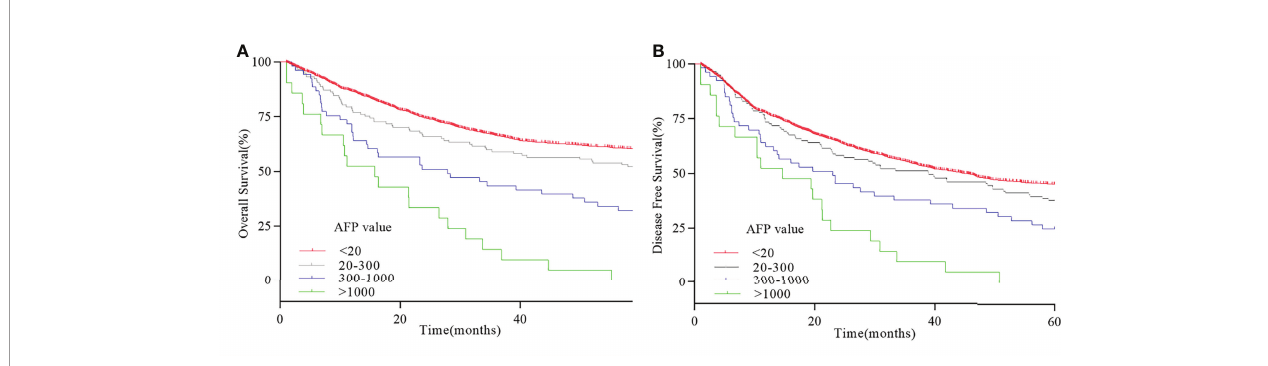
FIGURE 4 | Survival curve of serum AFP-positive GC. (A) 5-year OS curve with different serum AFP values. (B) 5-year DFS curve with different serum AFP values.